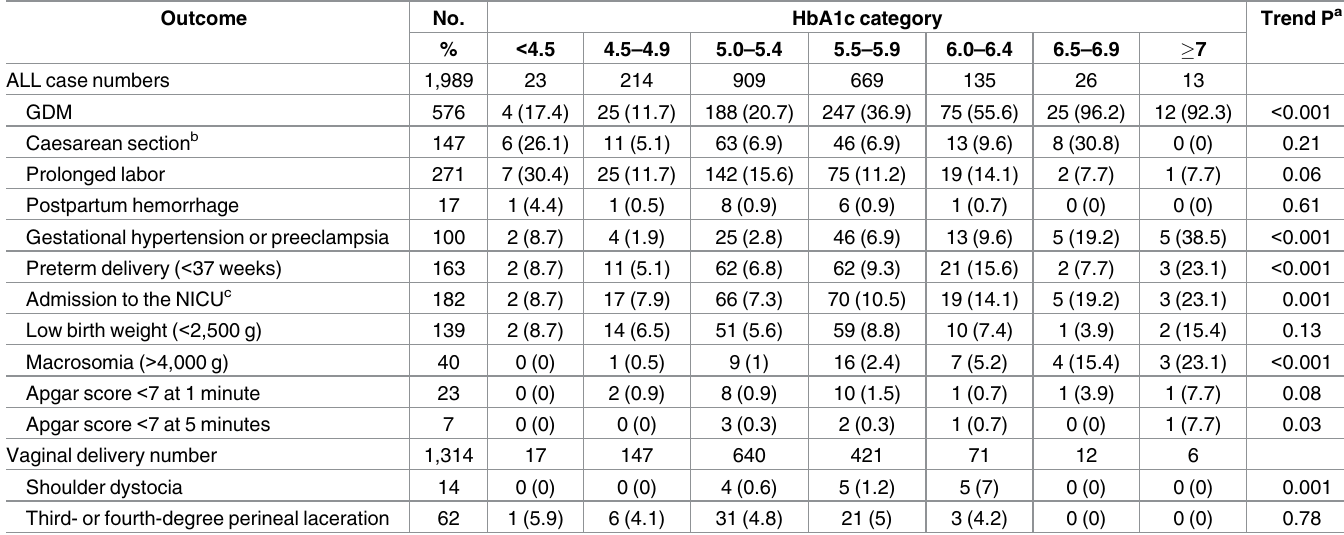
Table 1. Associations between HbA1c and pregnancy